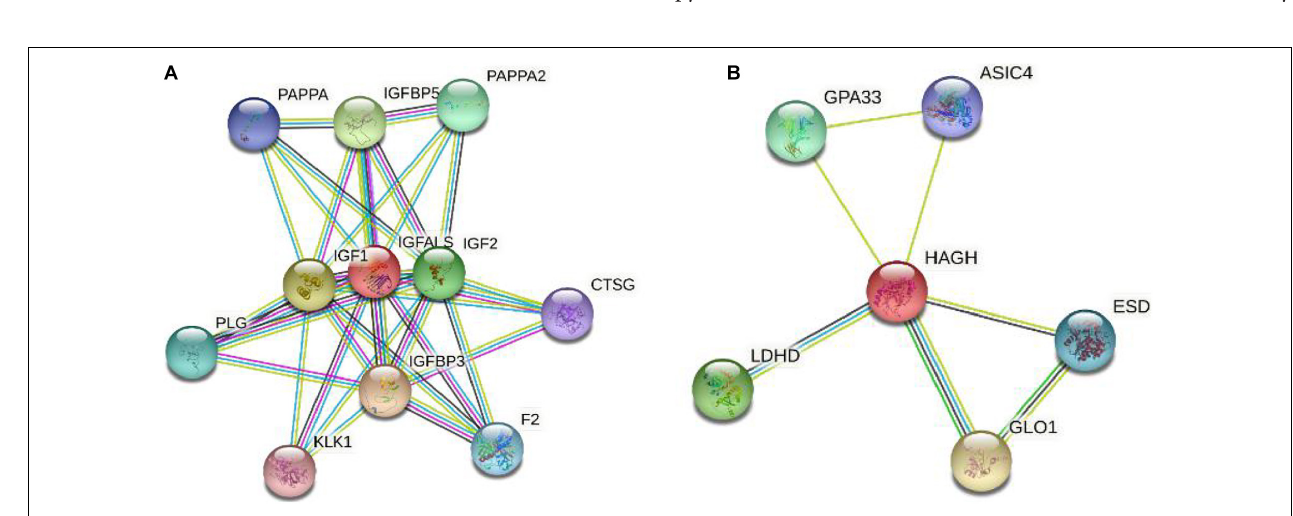
FIGURE 6 | Gene interaction network of IGFALS and HAGH. (A) Gene interaction network of IGFALS. (B) Gene interaction network of HAGH.